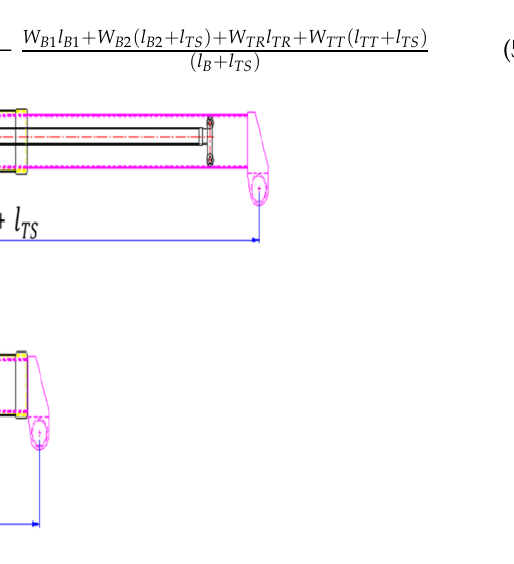
Figure 4. Dimension of the boom moment.